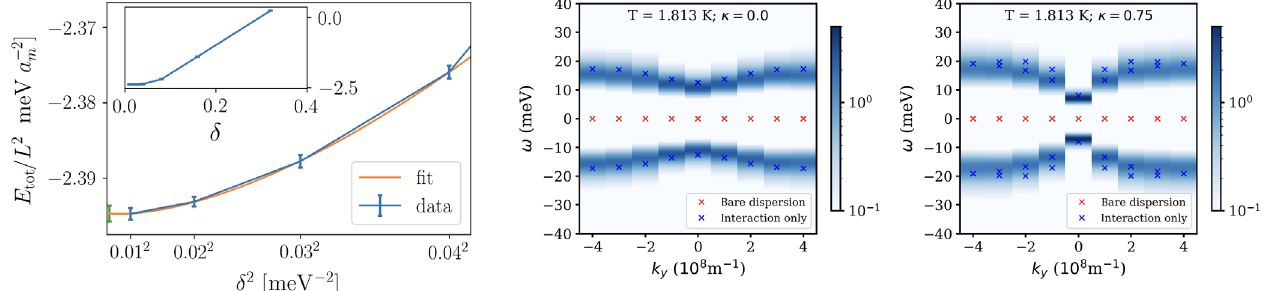
FIG. 10. Left panel: convergence of the energy density with Trotter step size δ . Here, we use the lowest temperature of T ¼ 1 . 8 K and κ ¼ 0 . 3 for the L ¼ 6 system. Right panels: comparison of the single-particle spectra obtained via MaxEnt from the DQMC simulation with exact results in the flat-band limit for (a) κ ¼ 0 . 0 and (b) κ ¼ 0 . 75 at T ¼ 1 . 8 K. The orange and green dots represent the noninteracting flat-band limit and the exact excitation energy of the interaction, respectively. The good agreement demonstrates the correctness of our DQMC